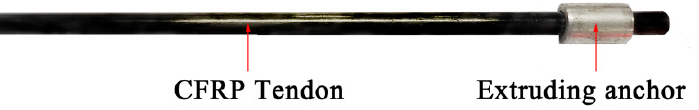
Figure 8. Assembly of CFRP tendon and extruding anchor.